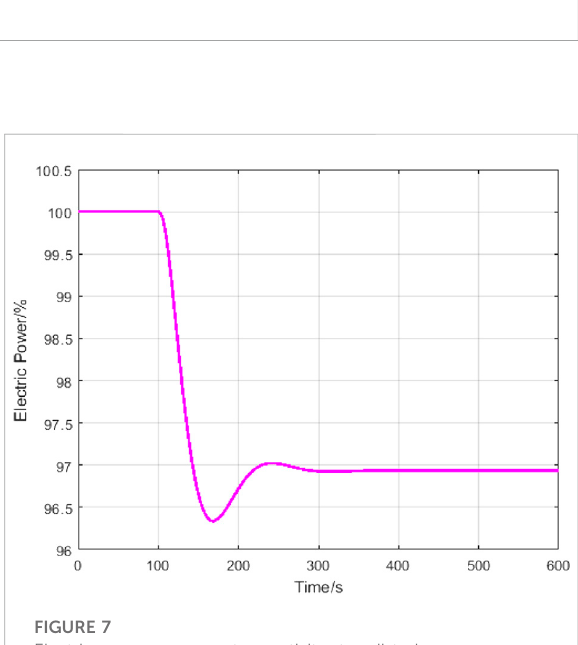
FIGURE 7 Electric power response to reactivity step